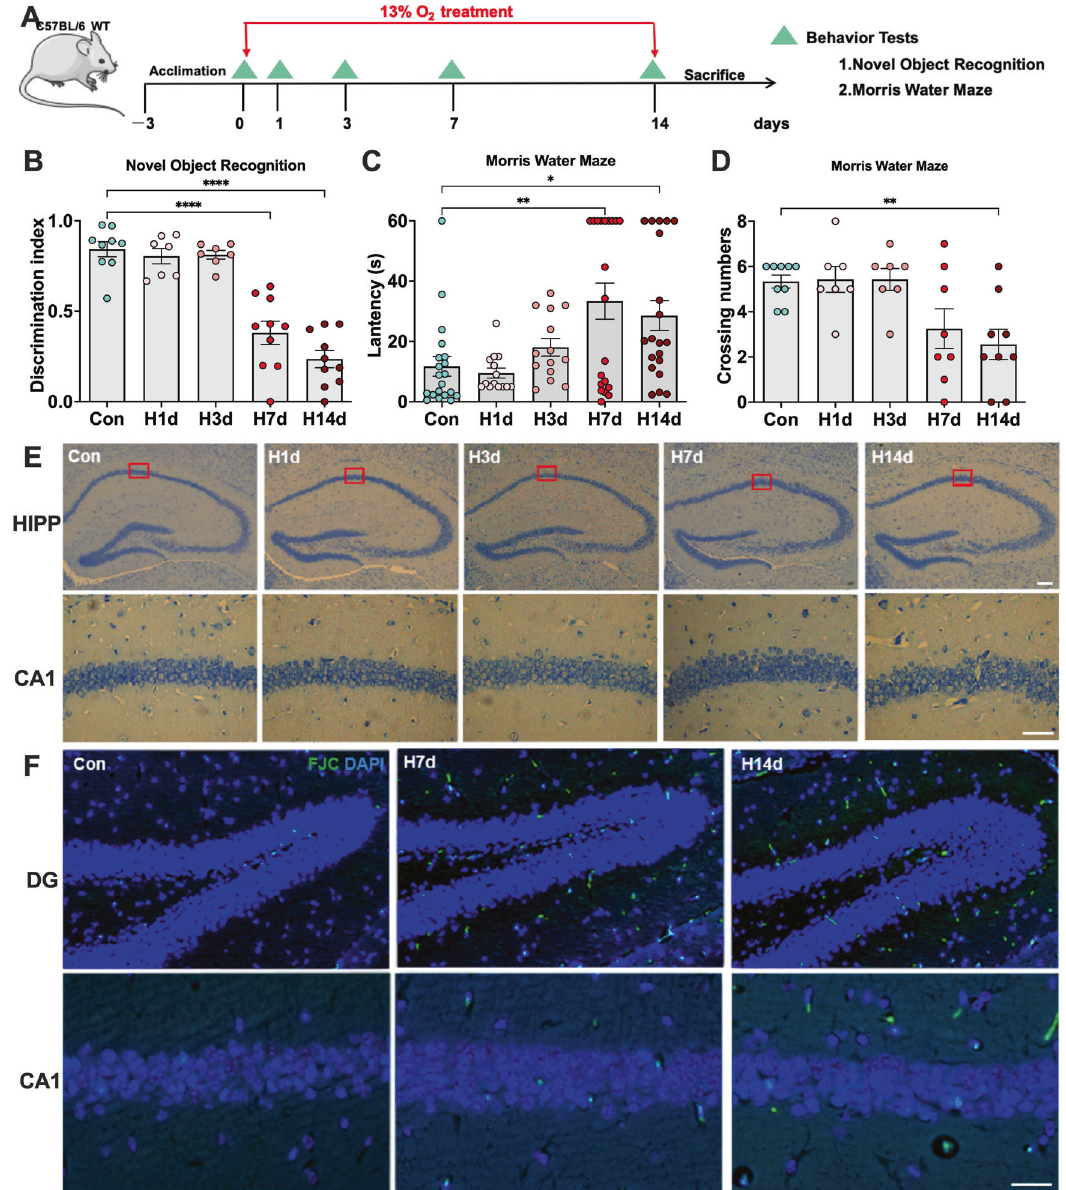
Fig. 1 Chronic hypoxia causes cognitive impairment in mice by promoting hippocampal neurodegeneration. A Mice received continuous hypoxia-inducing treatment for 0, 1, 3, 7, and 14 days (Con, H1d, H3d, H7d, and H14d), and underwent behavioral tests at different time points. B Detection and statistical analysis of the novel object recognition tests in mice of each group. C , D Detection and statistical analysis of the Morris water maze tests in mice of each group. E Nissl staining was used to evaluate the arrangement of neurons in the hippocampal (HIPP) CA1 region of each group. F Fluoro-Jade C (FJC) staining was used to evaluate the neurodegeneration of the DG and CA1 regions in the hippocampus of each group. Data are expressed as the mean ± SEM (one-way ANOVA). * P < 0.05, ** P < 0.01, **** P < 0.0001, n = 10. Bar = 50 μ m in E , F